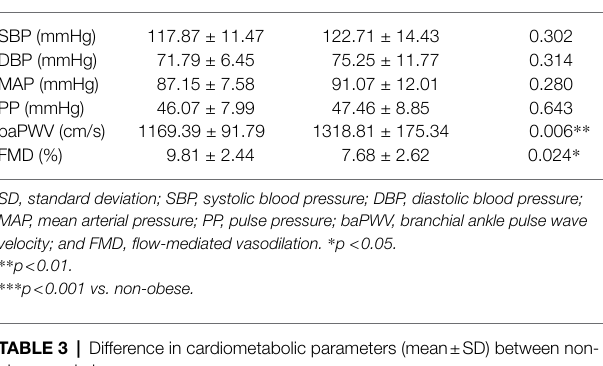
TABLE 2 | Difference in vascular function (mean ± SD) between non-obese and obese. Parameters